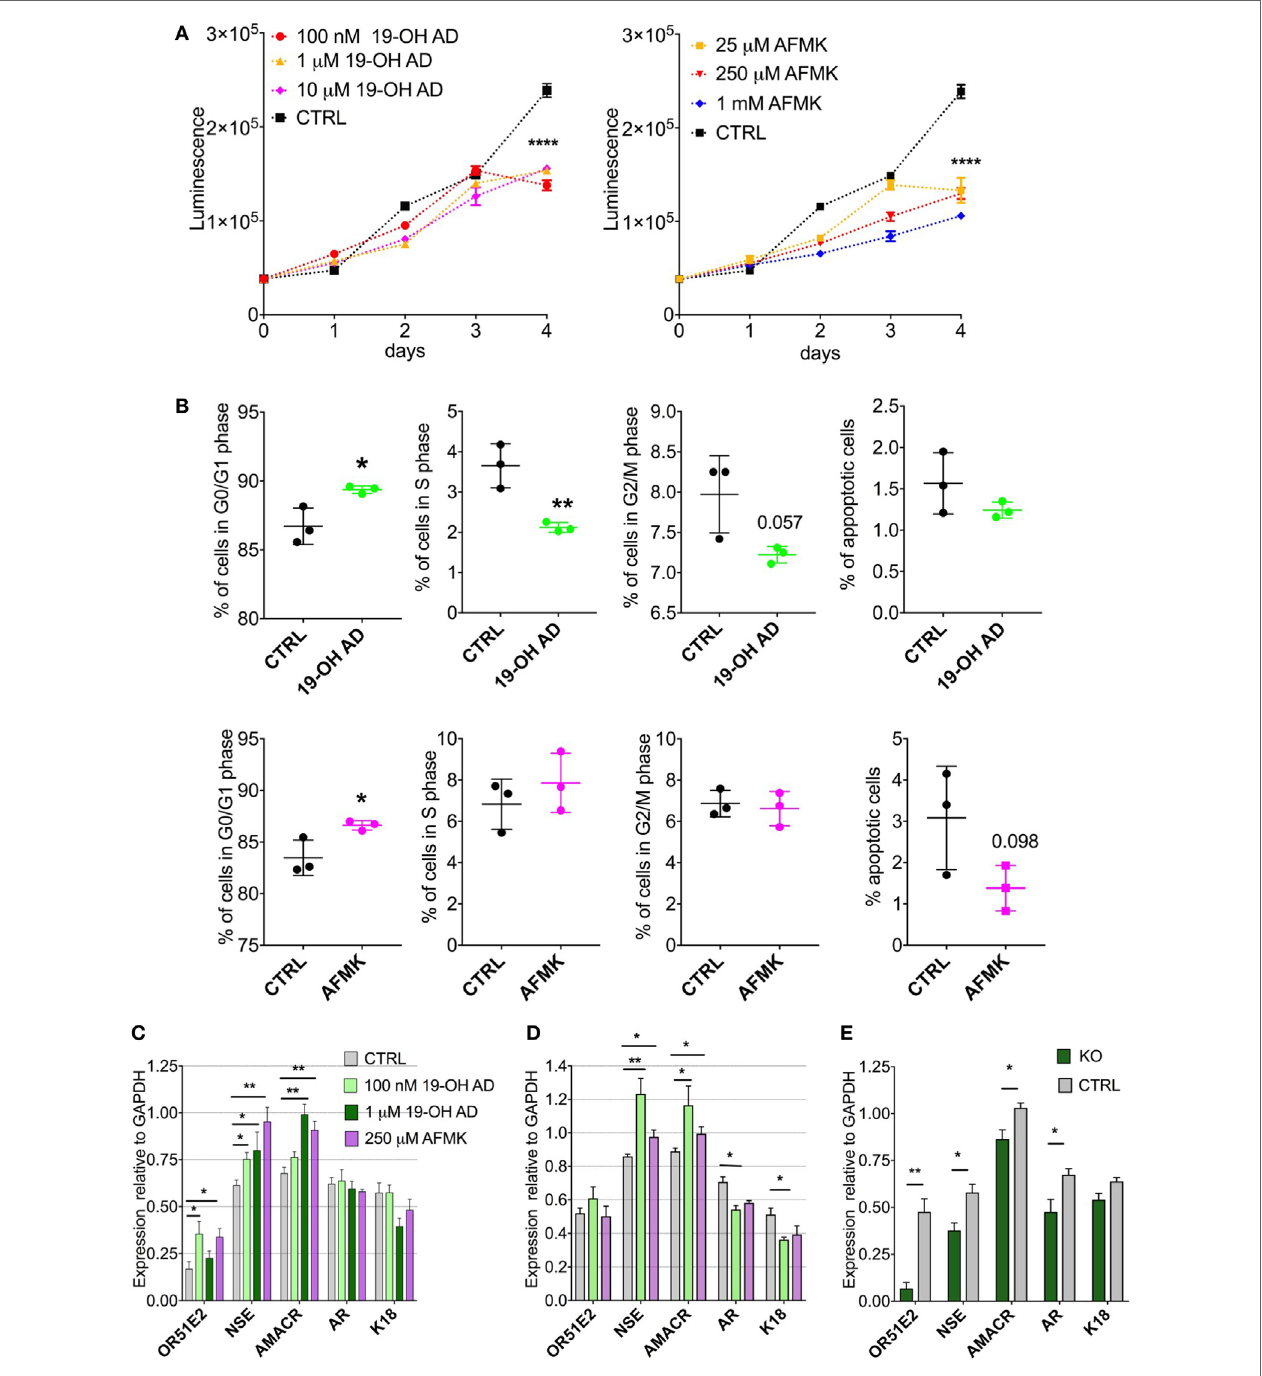
FigUre 5 | Activation of OR51E2 receptor by selected agonists induces a neuroendocrine phenotype. (a) Cell viability assay at various indicated concentrations of 19-OH AD and acetyl- N -formyl-5-methoxykynurenamine (AFMK). Cell viability correlates with luminescence signal. Statistical significance at day 4 with 100 nM 19-OH AD and 250 µM AFMK is **** P < 0.0001. (B) Cell cycle analysis after incubation with 100 nM 19-OH AD and 250 µM AFMK for 7 and 3 days, respectively. ( c) Transcript levels of markers after agonist stimulation for 3 days; N = 3–6, unpaired t -test, ** P < 0.01. * P < 0.05. (D) Transcript levels of makers after stimulation with agonists for 12 days, N = 3–6, unpaired t -test, ** P < 0.01. * P < 0.05. (e) Transcript levels of markers relative to GAPDH after 3 days of stimulation with 1 µM 19-OH AD in OR51E2-KO LNCaP cells. N = 4, mean ± SEM. ** P < 0.01. * P <